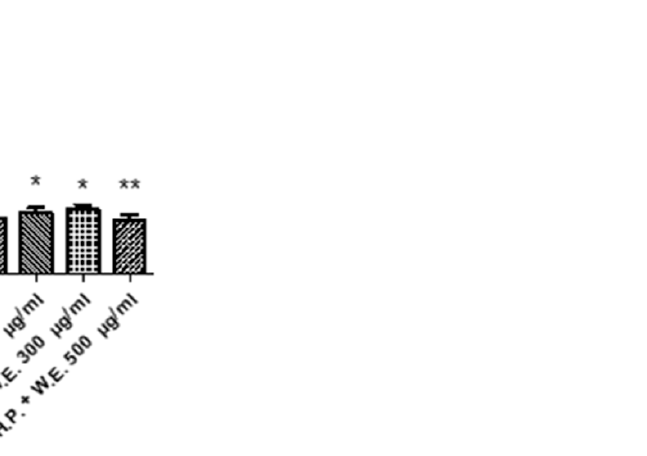
Figure 8. Inhibitory effect induced by Futura 75 water extract (W.E.) on prostaglandin (PG)E 2 production increased by hydrogen peroxide (H.P.) 1 mM, in isolated mouse skin specimens. ANOVA, P<0.01; **P<0.01, *P<0.05 vs. H.P.